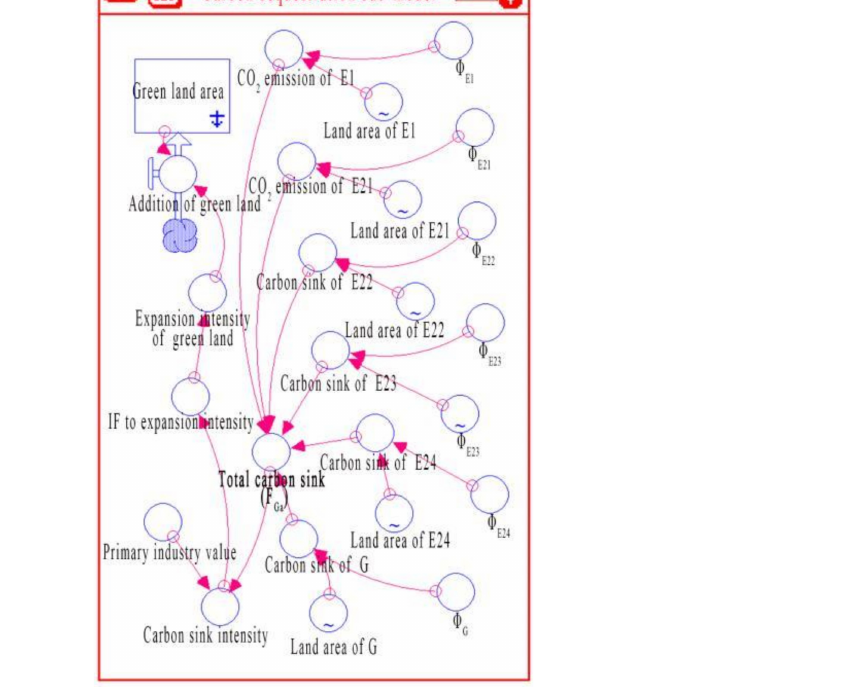
Figure 5. The CO 2 emissions stock and flow diagram of the carbon sequestration